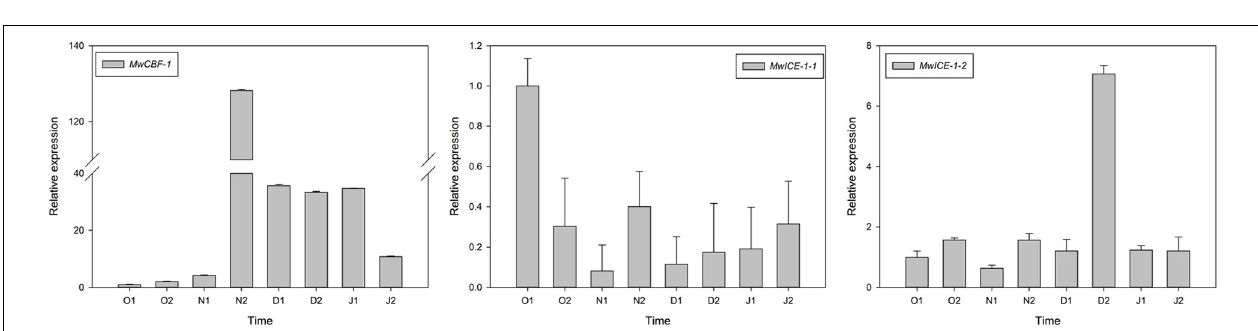
( Figure 9 ). The expression of MwCYCD-3 increased in